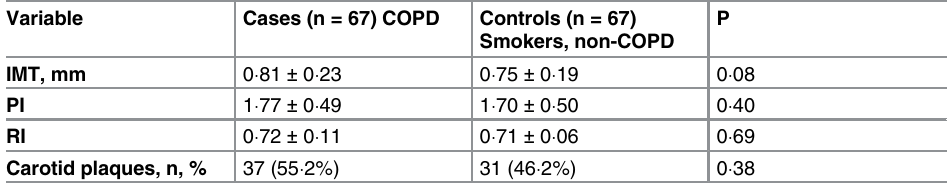
Table 6. Carotid ultrasound